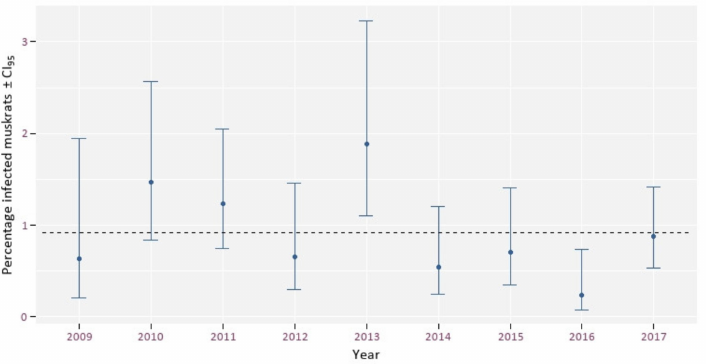
Figure 3. The percentage of EM infected muskrats in Flanders per year. The dashed line indicates an average infection rate of